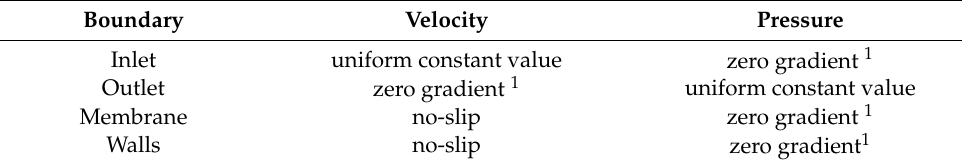
Table 1. Boundary conditions of the flow